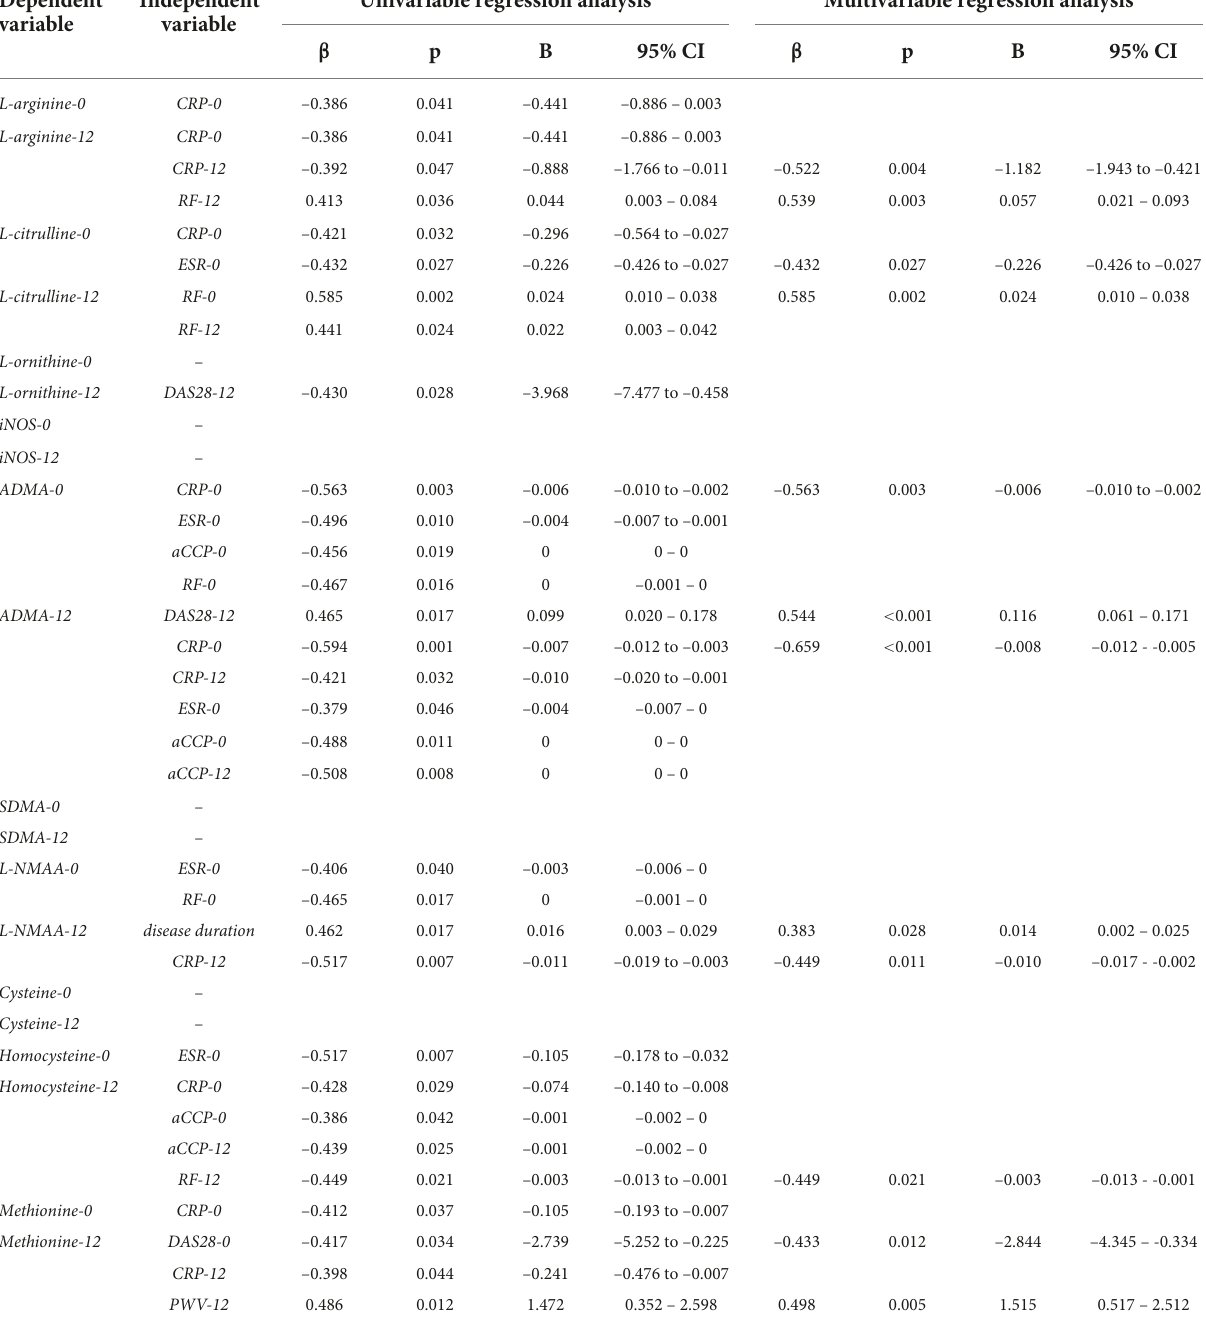
TABLE 2 Univariable and multivariable analysis of determinants of metabolites as dependent variables. Dependent